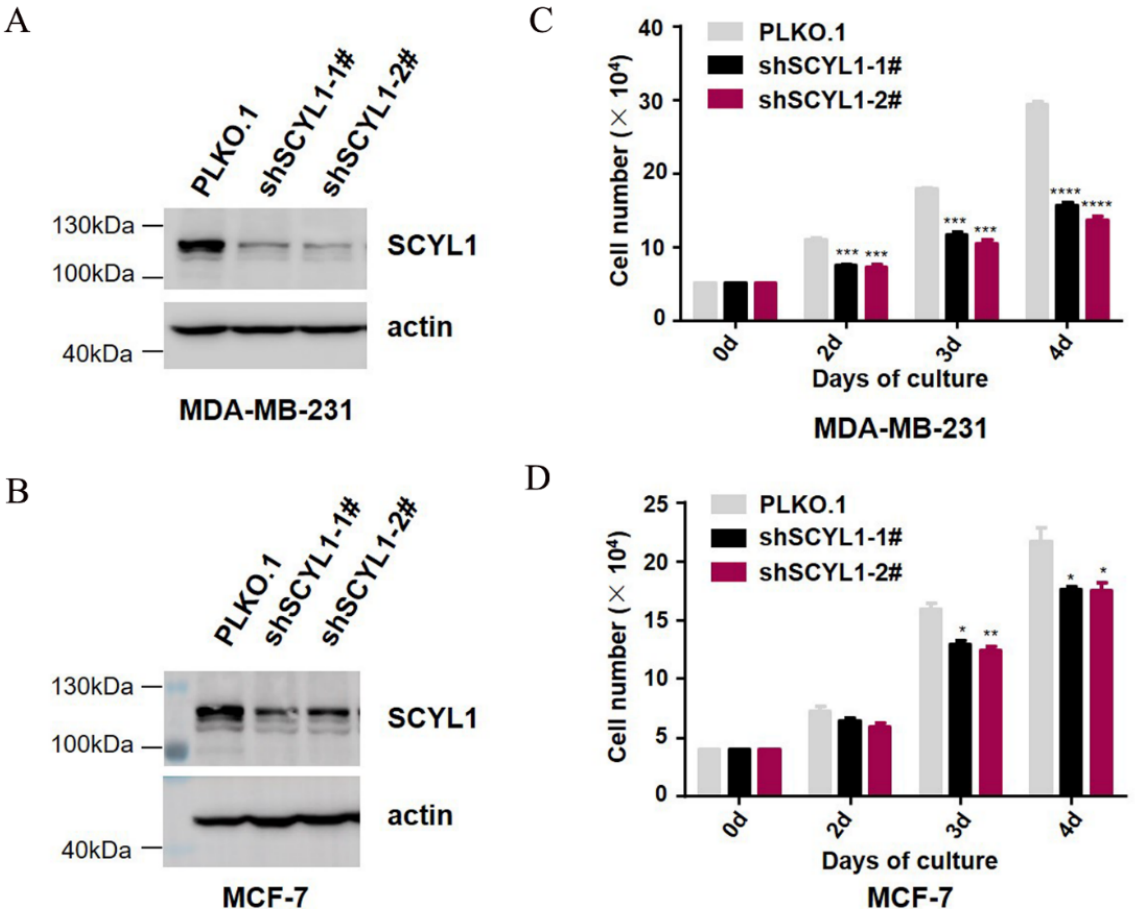
Figure 4. Knockdown of SCYL1 partially suppresses proliferation of BC cells. Endogenous SCYL1 was depleted by lentiviral vector-loaded SCYL1 shRNA for 48 h and detected by immunoblotting with anti-SCYL1 from the cell lysates. The effect of SCYL1 knockdown on cell proliferation was quantified by counting the cell number under a phase microscope with a hemocytometer. The data used for quantification were from three independent experiments. ( A , B ) SCYL1 expression at protein levels in MDA-MB-231 and MCF-7 cells. ( C , D ) The effect of SCYL1 knockdown on MDA-MB- 231 and MCF-7 cell proliferation. *: p -value < 0.05; **: p -value < 0.01; ***: p -value < 0.001.